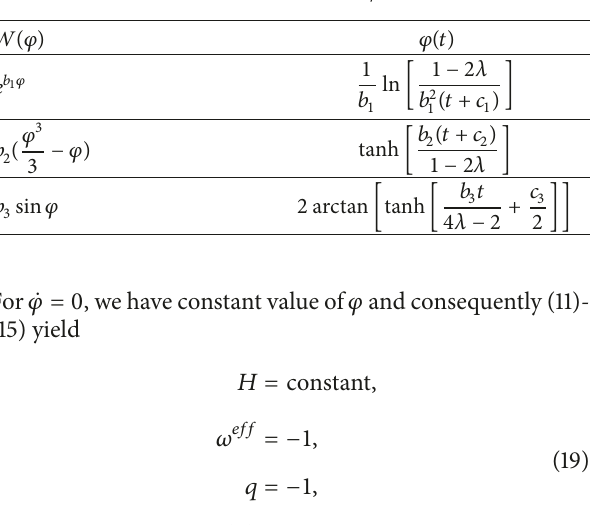
− , 𝑏 1 = 0.001(1/𝑠𝑒𝑐) , and 𝜑 − (0) = 0.01 when 𝑘 = −1 .